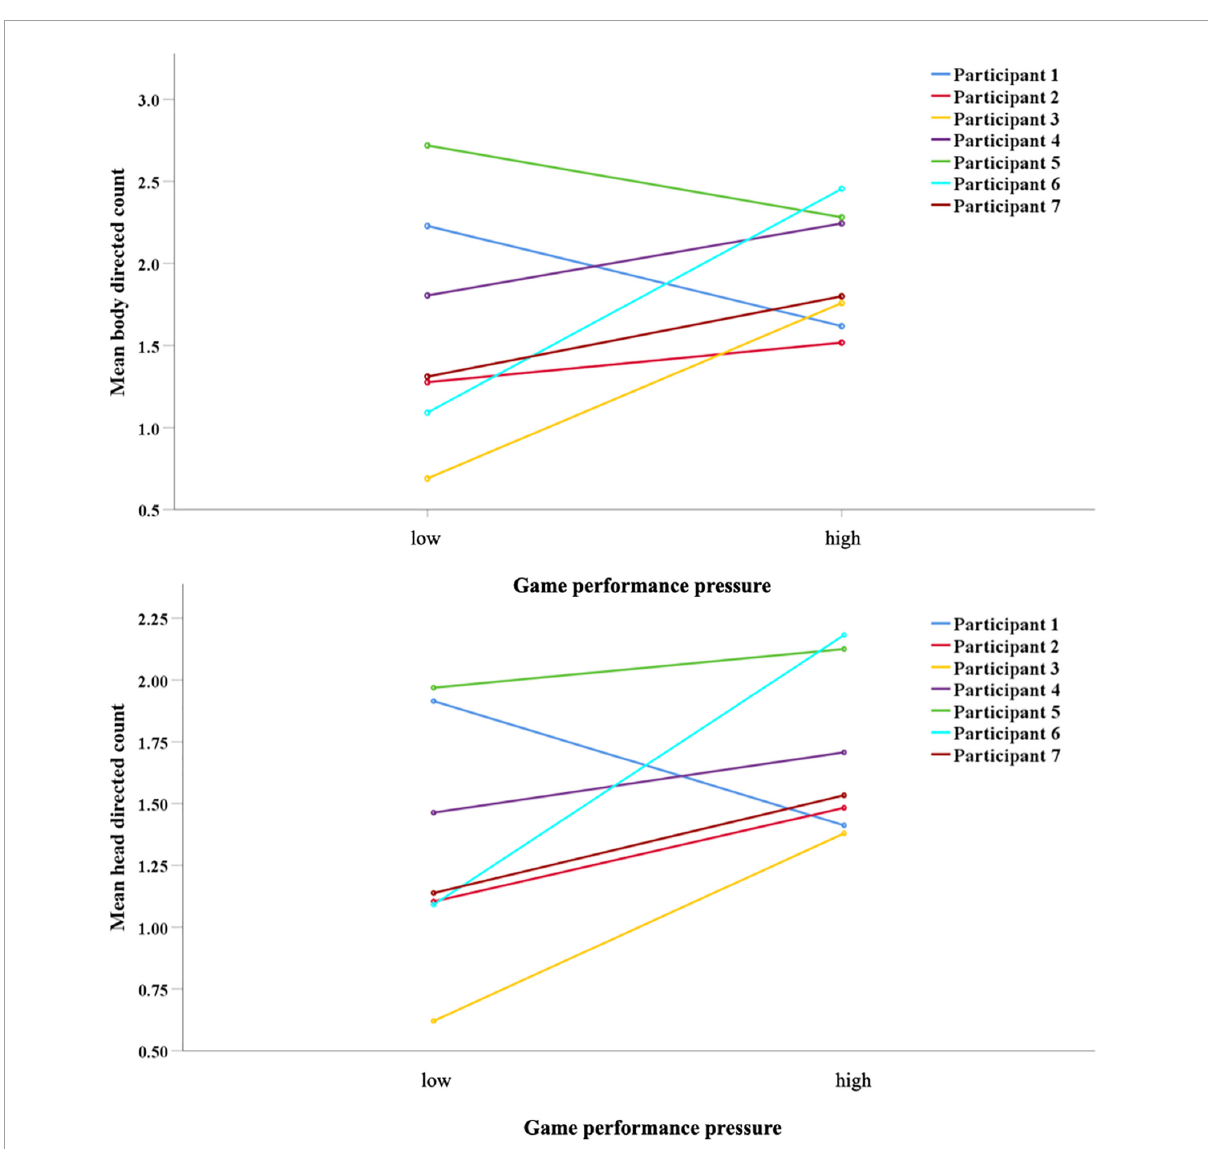
FIGURE4 Mean fixation numbers on the face (A) and the environment (B) per participant for the high- and low game performance pressure